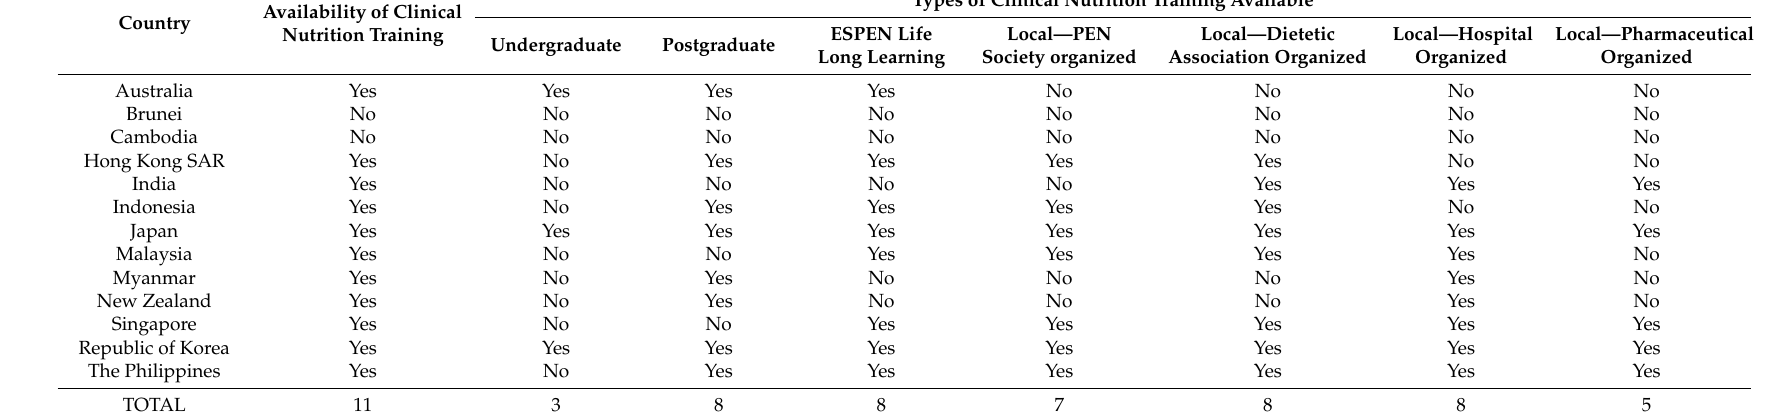
Table 5. Clinical Nutrition Education in Countries Participating in the Survey. ESPEN: The European Society for Clinical Nutrition and Metabolism; PEN: Parenteral and Enteral